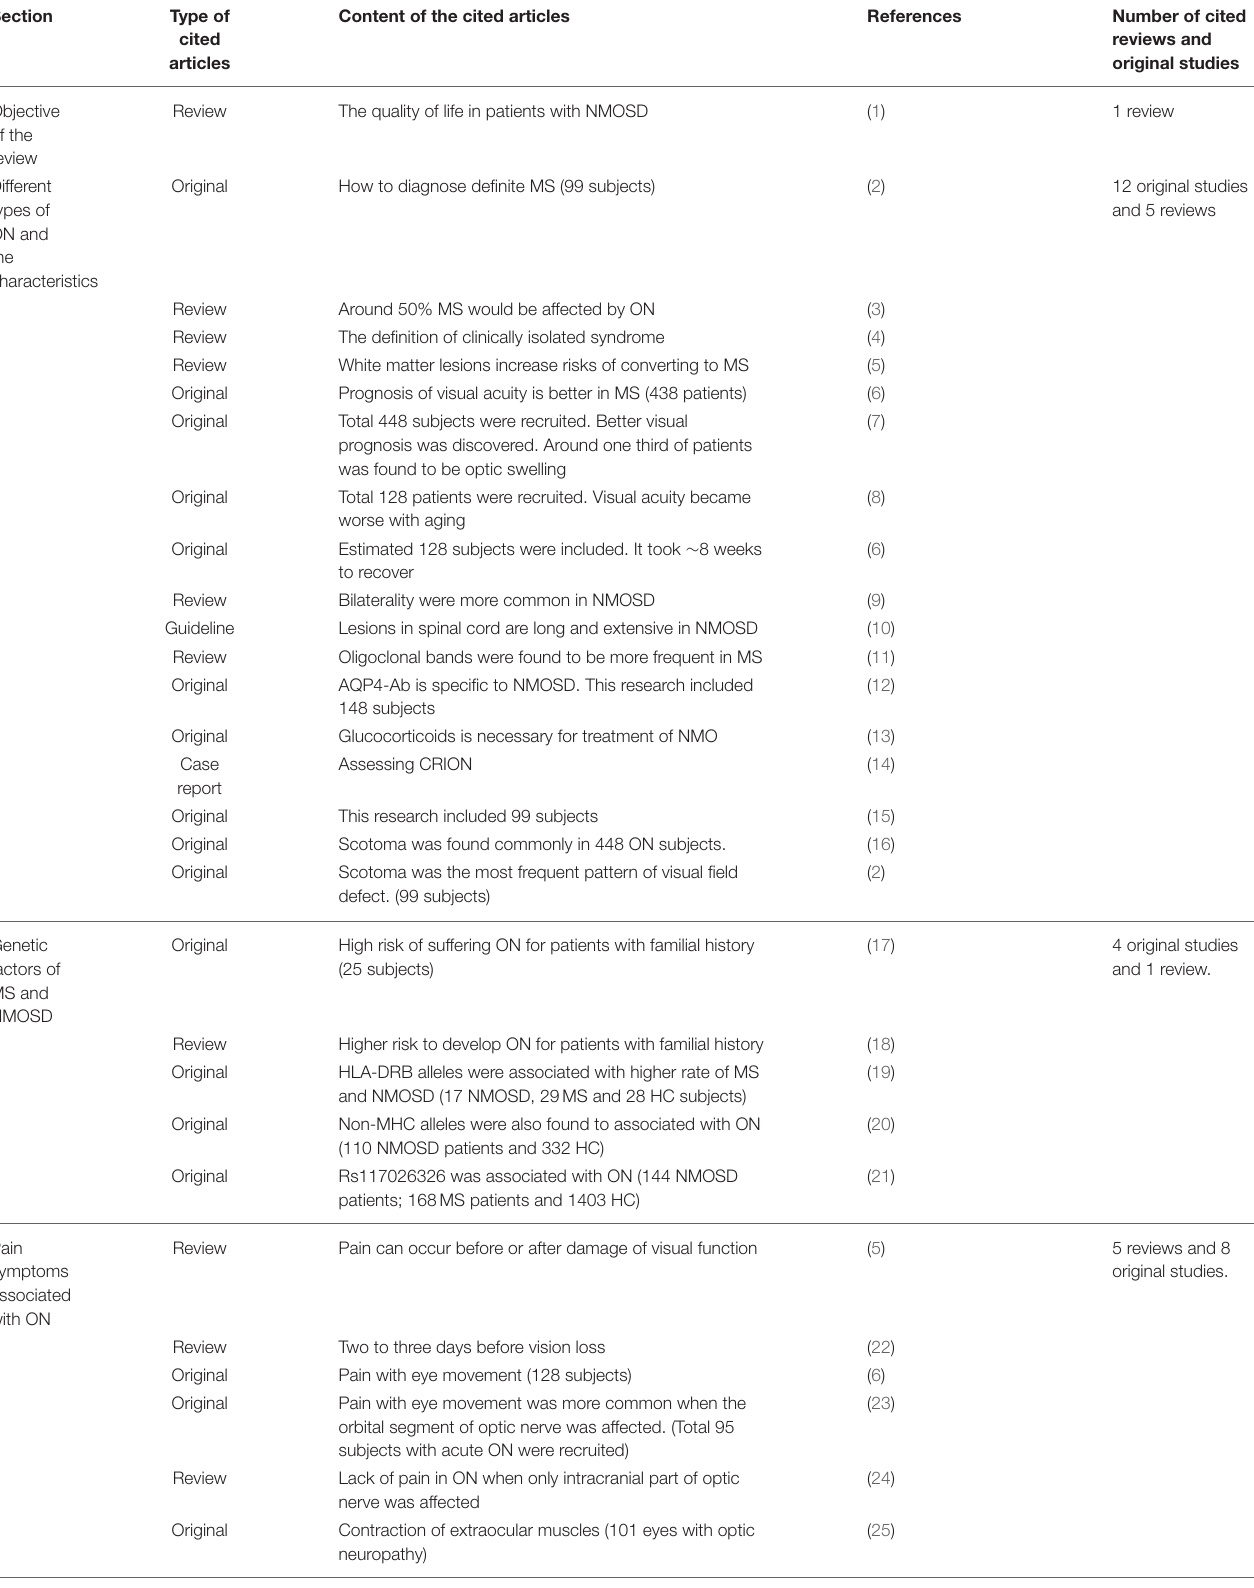
TABLE 1 | Summary of cited article in each